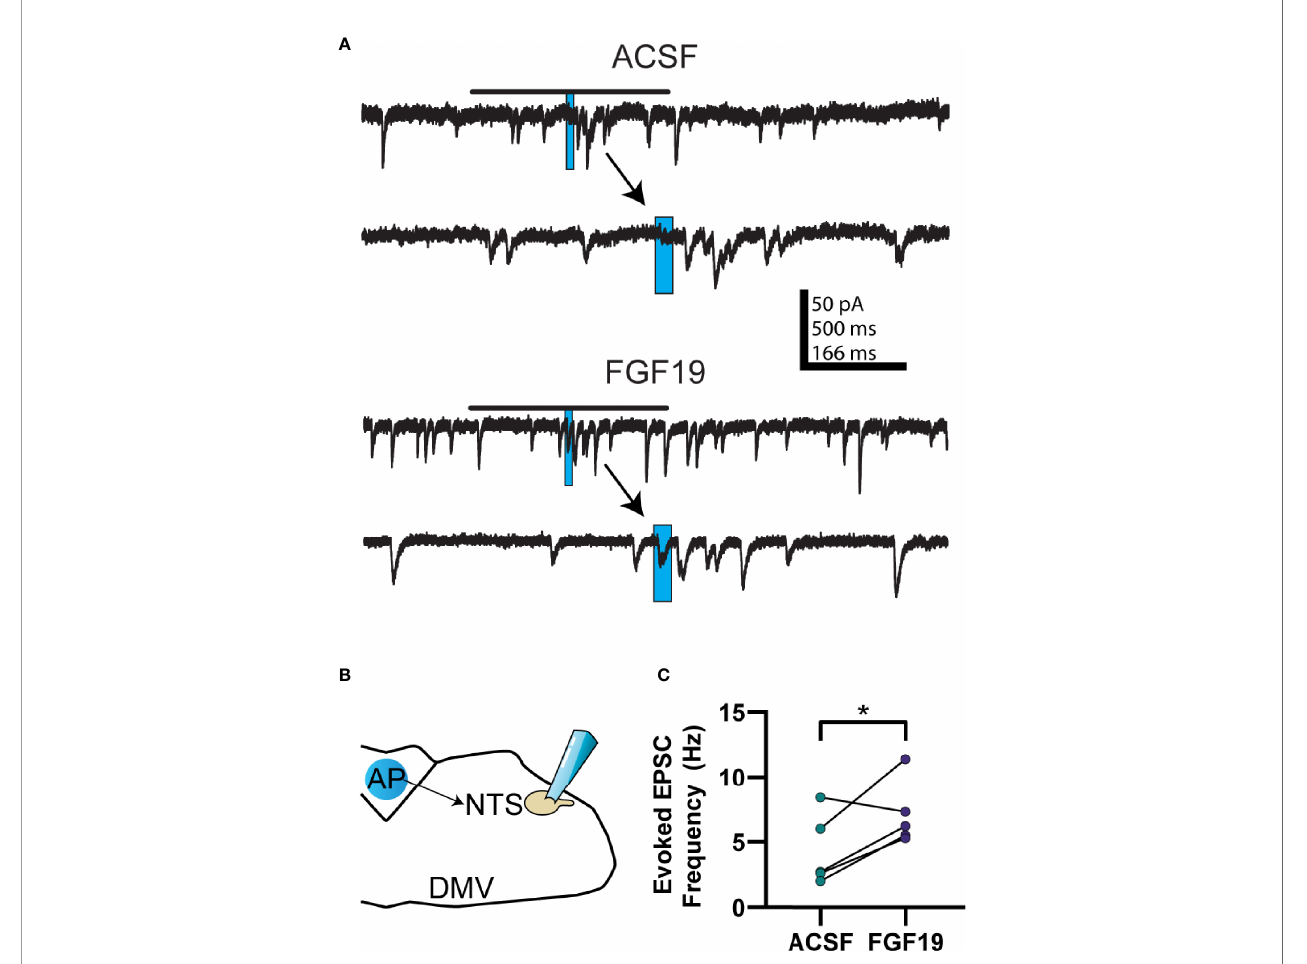
FIGURE 5 | FGF19 increases the excitability of glutamatergic AP neurons that project to the NTS in hyperglycemic mice. (A) Representative voltage clamp recordings of evoked EPSCs for the AP to NTS circuit in T1DM mice. (B) Diagram showing a typical stimulation and recording regions for cells in (A, C) . (C) Evoked EPSC response in this group before and after addition of FGF19 (n = 5; *p < 0.05). In representative traces, blue rectangle indicates stimulation time and duration. Arrows point to an expanded trace showing 500 ms before and after stimulation. All cells recorded at -85 mV. Paired t-test used for analysis. All recordings performed in MNI-caged glutamate (250 µM) and picrotoxin (100